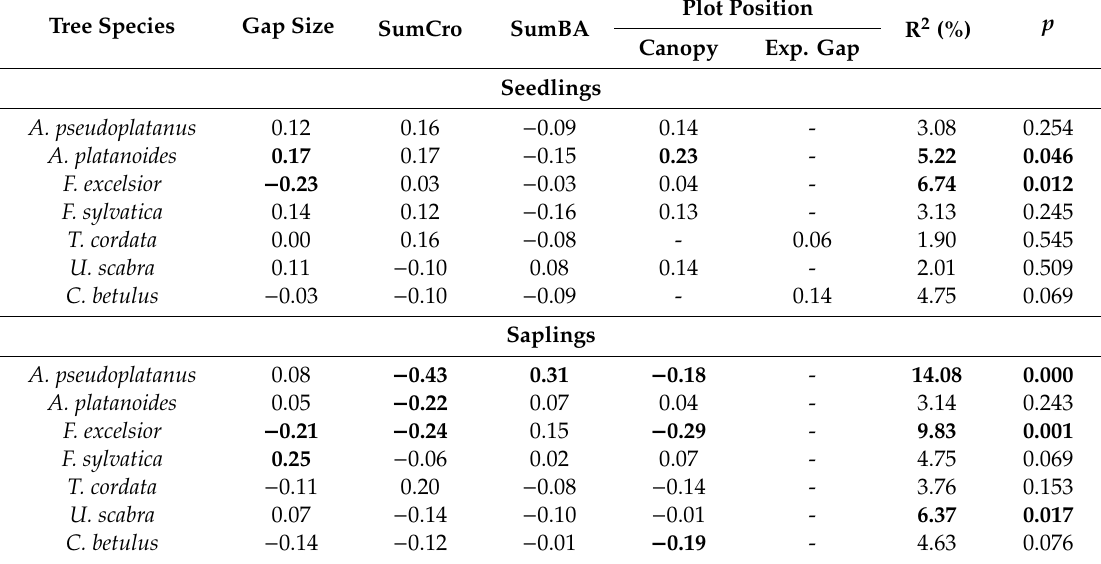
Table 7. Regresion β -coe ffi cients obtained from general linear models for each individual tree species and height growth category of natural regeneration in relation to independent environmental factors, displayed are R-squares of the whole models and their p -values. Tree